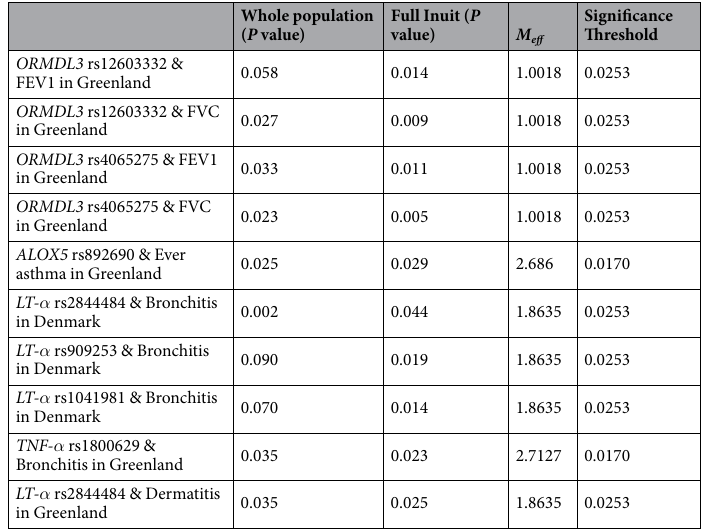
Table 2. Correction for multiple comparisons in the significant associations identified. M eff : the effective number of SNPs tested within each